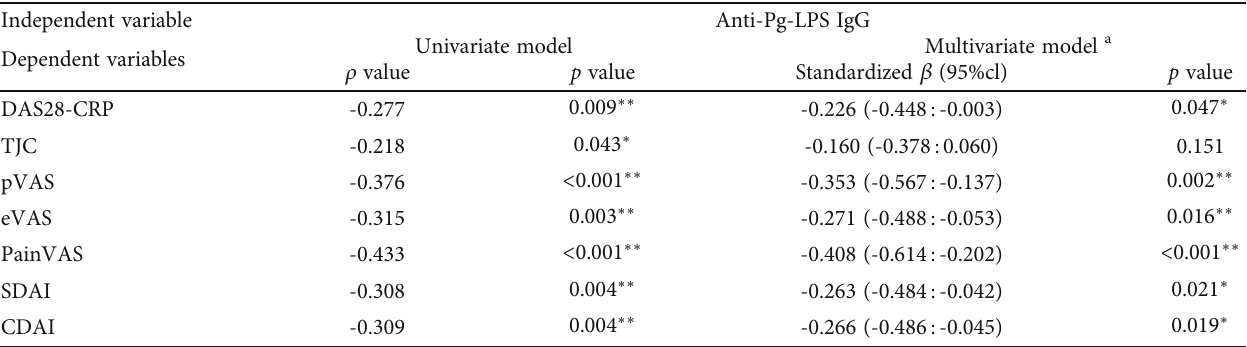
Table 4: Univariate and multivariate regression analyses between anti-Pg-LPS IgG levels and RA disease activity indices. Independent